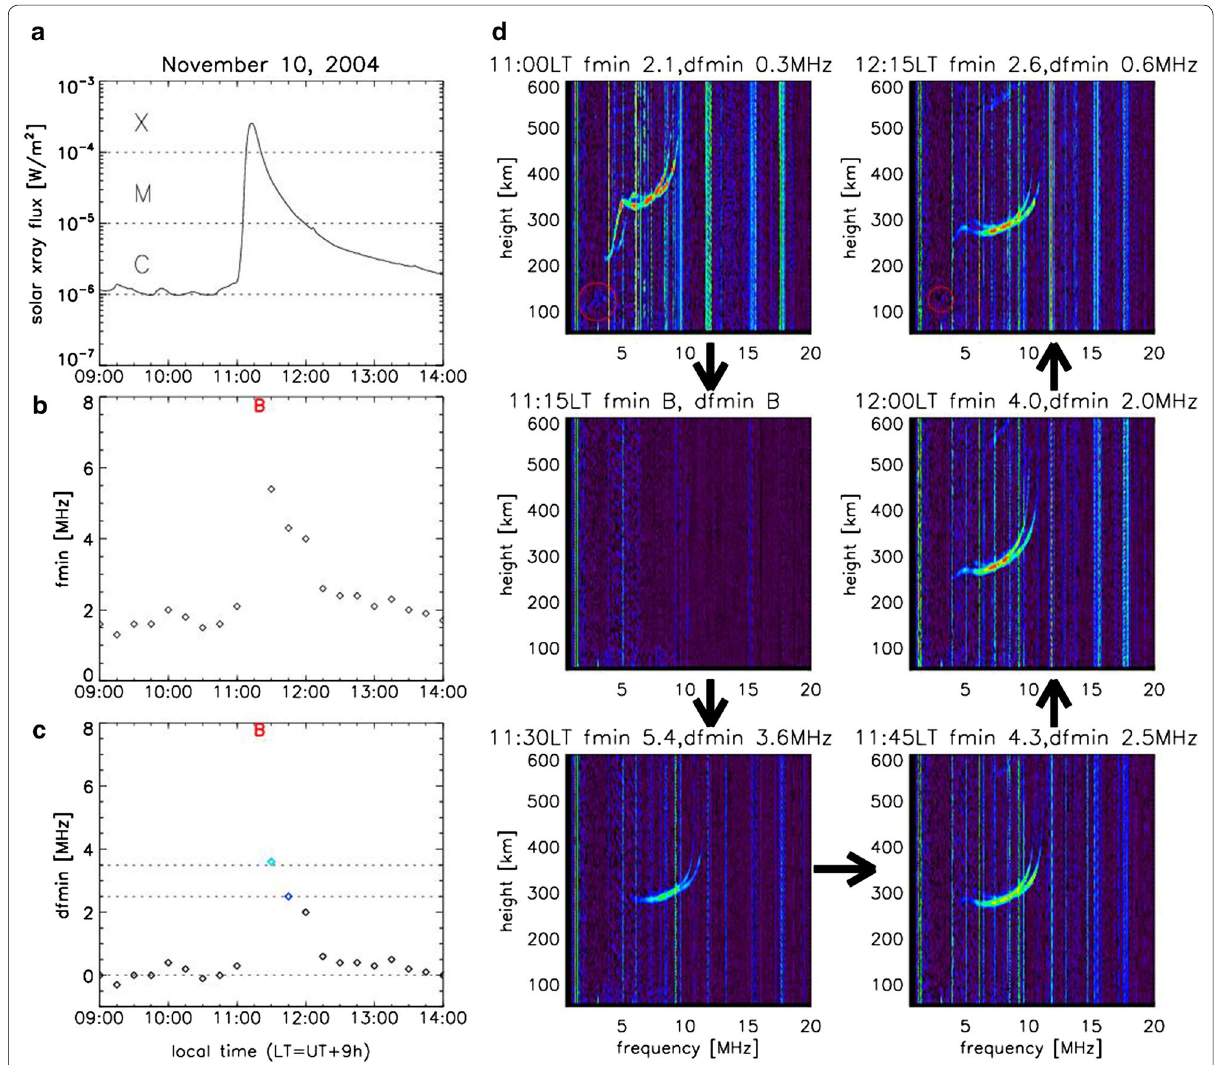
Fig. 1 Time variations in a solar X-ray flux, b f min, c d f min, and d ionograms during solar flare events on November 10, 2004. The f min and d f min values of the blackout period are shown as “B” in red in b, c. d f min respectively, in c. The weak echo signal at ~ 3 MHz at altitudes of 100–150 km is surrounded by red circles in d at LT 11:00 and